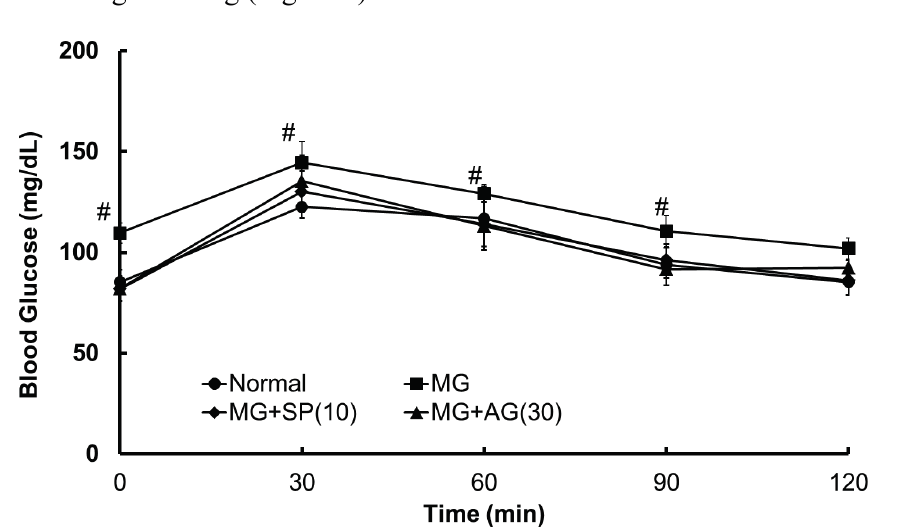
weight); MG + SP (10): methylglyoxal (300 mg/kg body weight) + scopoletin (10 mg/kg body weight); MG + AG (30): methylglyoxal (300 mg/kg body weight) + aminoguanidine (30 mg/kg body